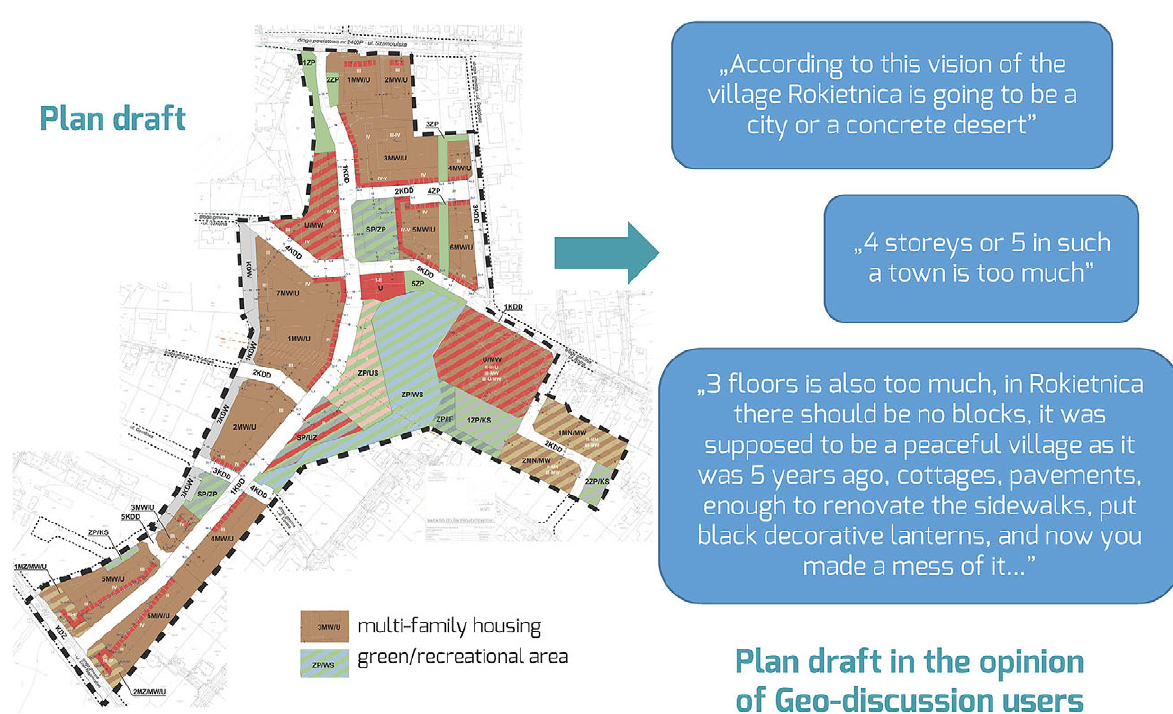
Fig. 5. Comments on draft plan of land use of the Rokietnica centre (by D. Walczak and M.